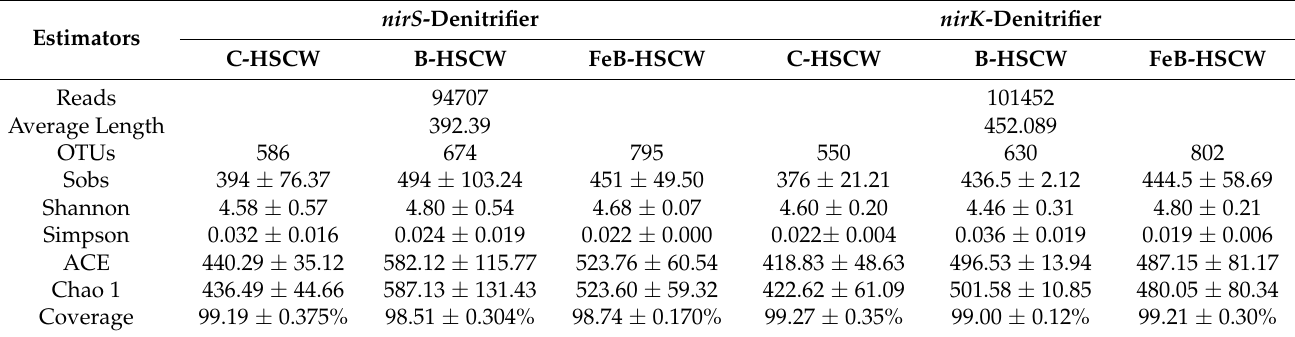
Table 1. The richness and diversity of nirS - and nirK -denitrifier communities in the three constructed wetlands (HSCWs); n = 6.